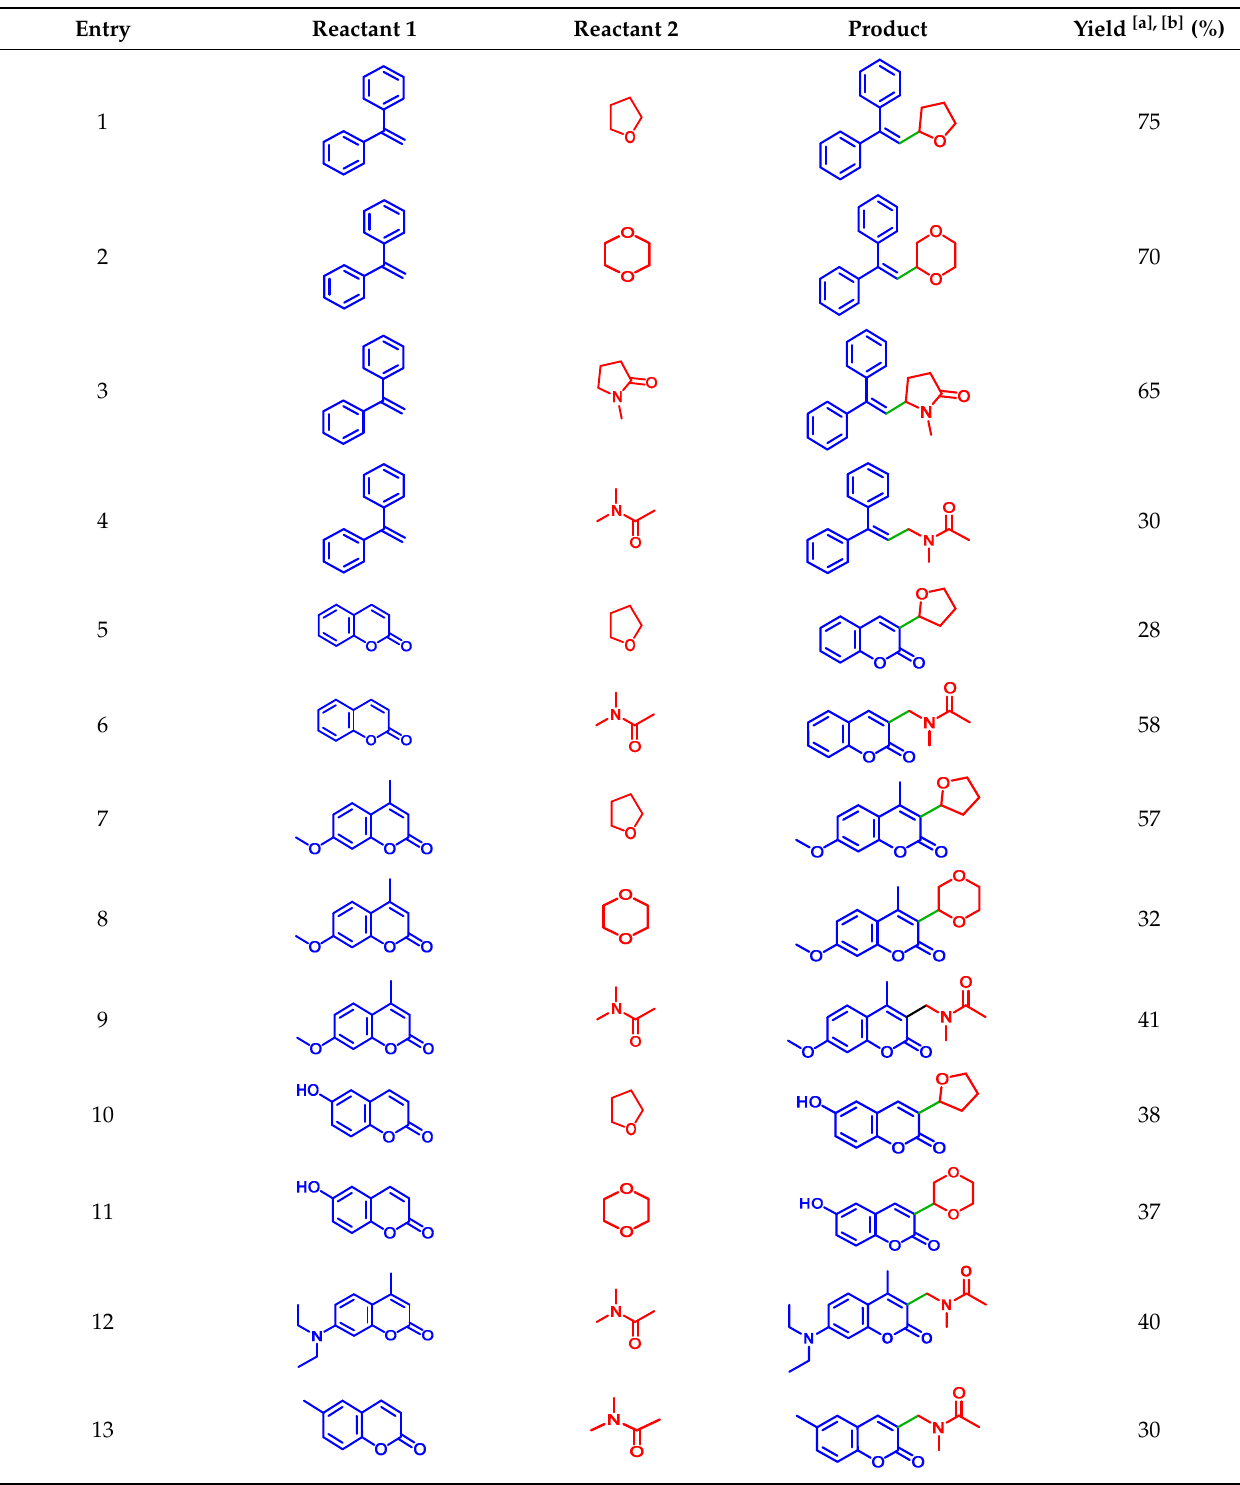
a Reaction conditions: reactant 1 (0.3 mmol); reactant 2 (1 mL); DTBP (4 equiv.); KI (20 mol%); Cu 1 Ce 0.7 Si catalyst (8.4 mg); 120 °C; under air for 25 h. b Isolated yield.